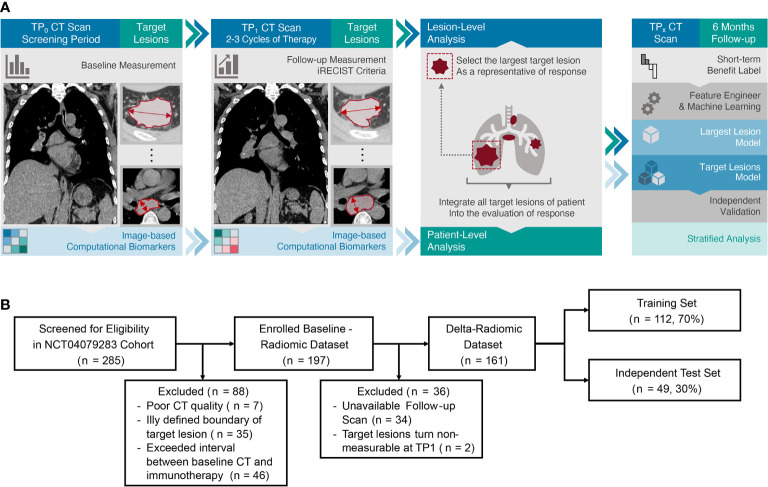

(A) Study workflow. The workflow presented a summary of target lesions annotation and response assessment, preprocessing and modeling schemes of radiomics. (B) Patient flow diagram. For baseline-radiomic dataset, training and test set were randomly divided in a proportion of 7:3 respectively as well.